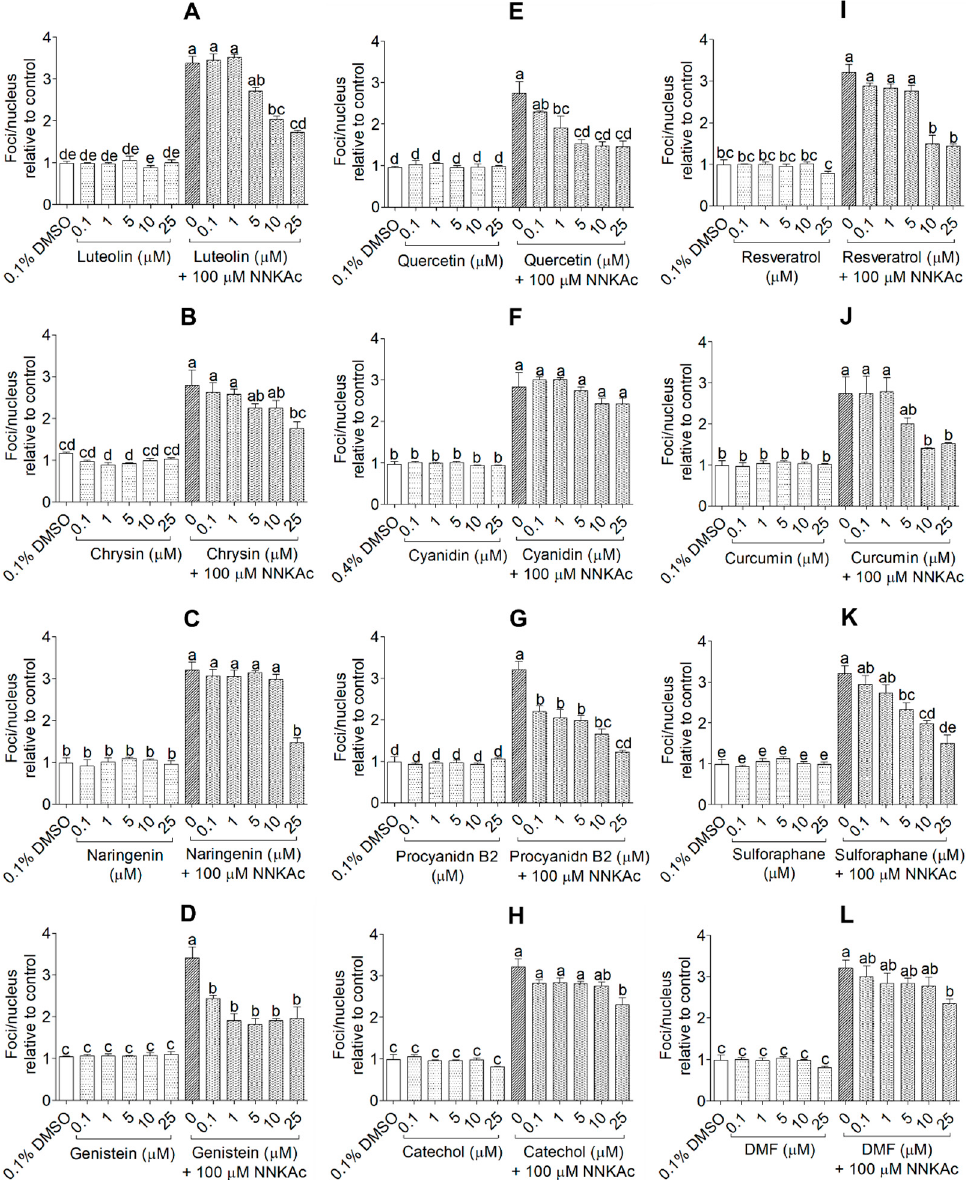
Figure 6. Effect of luteolin ( A ), chrysin ( B ), naringenin ( C ), genistein ( D ), quercetin ( E ), cyanidin ( F ), procyanidin B2 ( G ), catechol ( H ), resveratrol ( I ), curcumin ( J ), sulforaphane ( K ), and DMF ( L ) on NNKAc-induced DNA damage in BEAS-2B cells measured by γ -H2AX immunofluorescence assay. Cells were pre-treated with concentrations ranging from 0.1 to 25 µM of selected compounds for 3 h. Pre-treated cells were exposed to 100 µM NNKAc for another 3 h. DMSO (0.1%) was used as the vehicle control. Specific antibodies were used to label the phosphorylated histone γ -H2AX foci (S139) and DAPI was used to stain the nucleus. The foci/nucleus ratio was quantified using at least 50 nuclei per treatment. Nuclei were imaged by fluorescence microscopy (×100 magnification). The foci per nuclei were counted by ImageJ software (Version 1.53k, National Institute of Mental Health, Bethesda, MD, USA). Three independent studies were performed, and results were expressed as mean ± standard deviation. Statistical analysis of data was performed by one-way ANOVA and mean comparison was done by Tukey’s mean comparison method ( α = 0.05) using Minitab 19 statistical software (LLC, Pennsylvania, USA). Mean values that do not share similar letters in bar graphs are significantly different ( p < 0.05). Abbreviations: NNKAc: 4-[(Acetoxymethyl)nitrosamino]-1-(3-pyridyl)-1-butanone, DMF: dimethyl fumarate, DMSO: dimethyl sulfoxide.